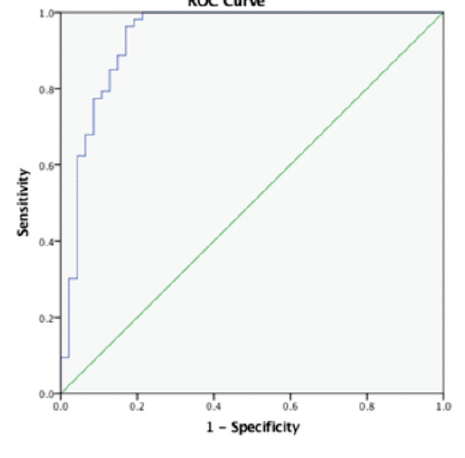
Figure 1: ROC curve for Platelet per spleenic diameter (AUC - 0.935)